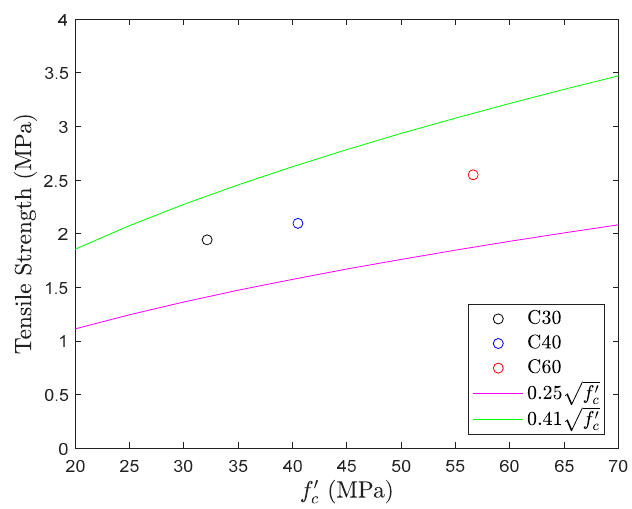
ffi cient of strut-and-tie beam Figure 22. (cid:1858) (cid:3030) ′ coefficient of strut-and-tie beam test. Figure 22. f (cid:48) c coe Figure 22. (cid:1858) (cid:3030) ′ coefficient of strut-and-tie beam test.